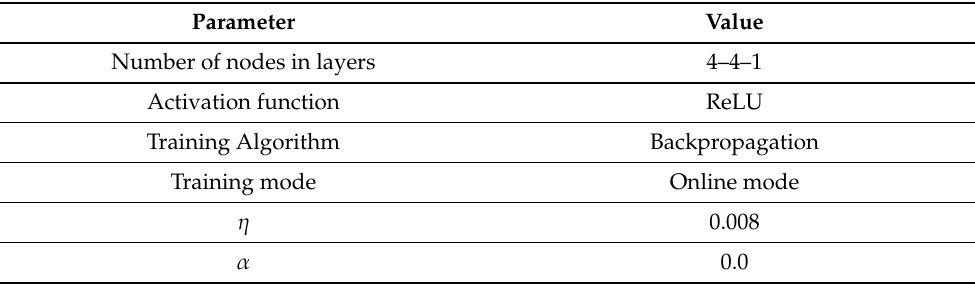
Table 1. Parameters used for implementation MLP-BP and RMLP-BP